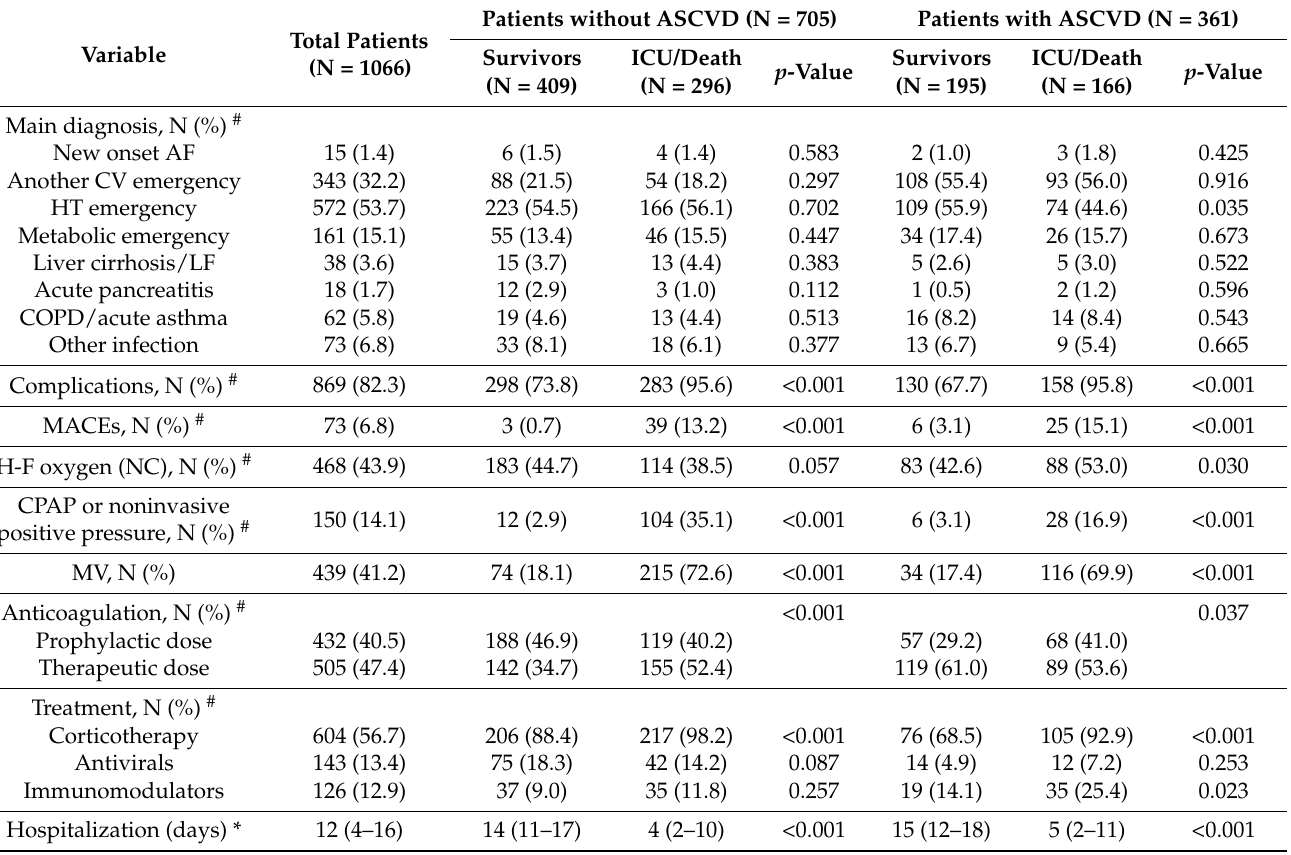
Table 2. Patients’ reason for admission, treatment and outcome characteristics by history of Atherosclerotic Cardiovascular Disease (ASCVD) and composite